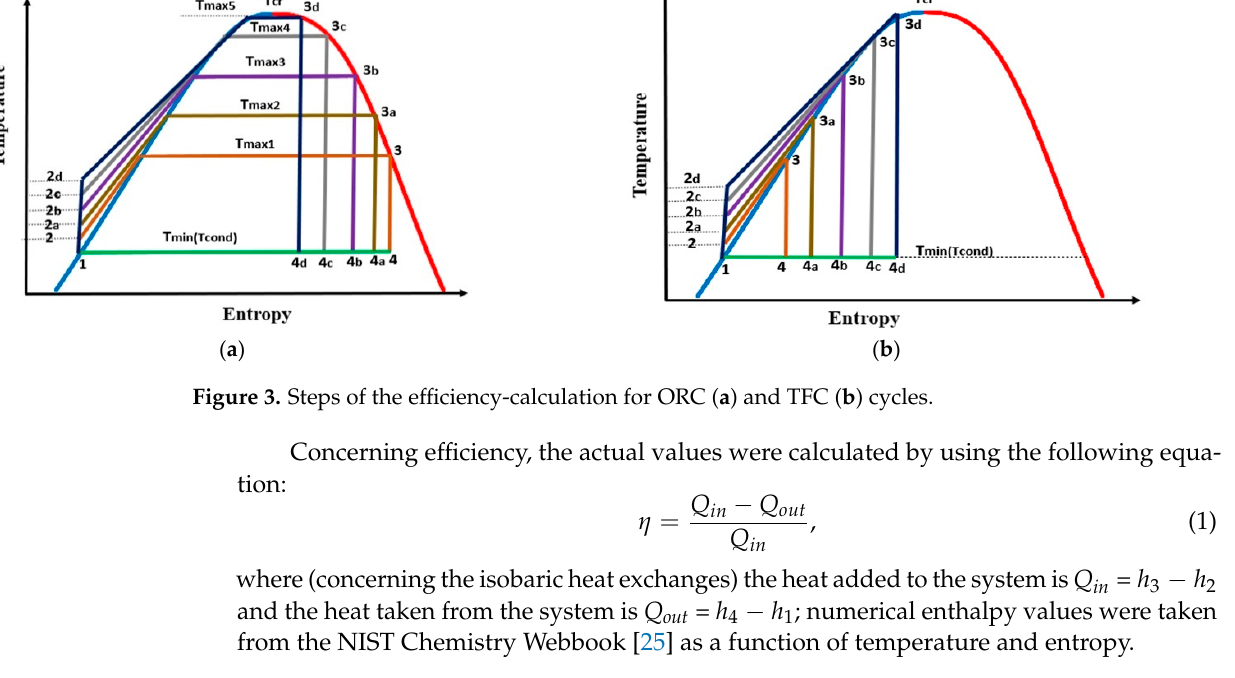
Figure 2. Temperature dependencies of ORC (or other Rankine-like) and TFC cycles for various working fluids (Water ( a ), CO 2 ( b ), R116 ( c ), Butane ( d ), Neopentane ( e ), Dodecane ( f )); see text for further explanation.